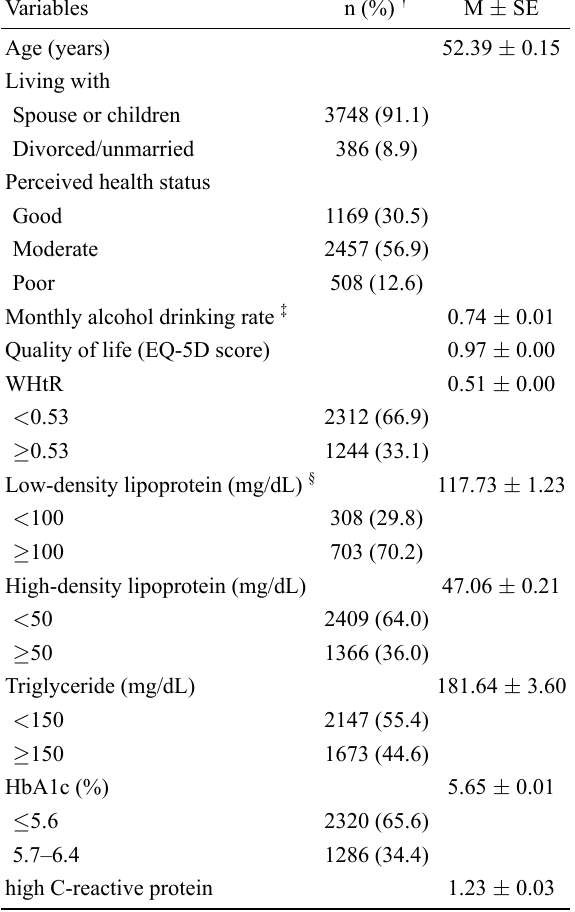
Table 1. Characteristics of the participants (N =